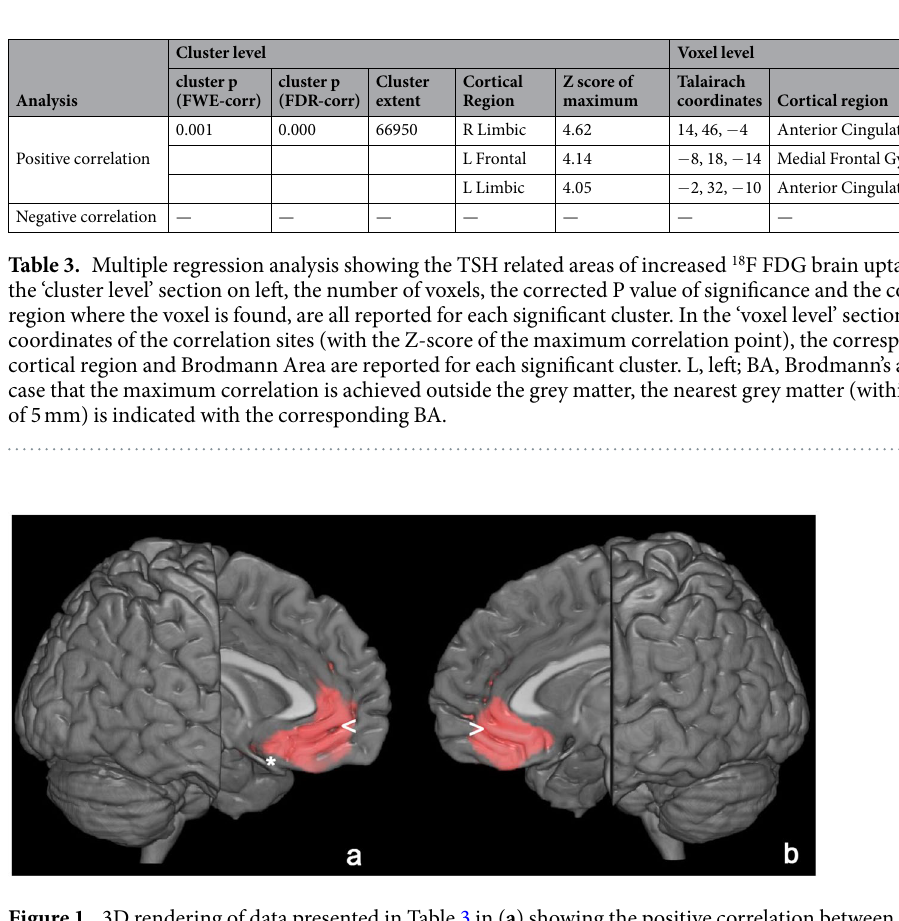
Figure 1. 3D rendering of data presented in Table 3 in ( a ) showing the positive correlation between TSH and brain glucose consumption in left anterior cingulate cortex ( < ) and medial frontal gyrus ( * ) and in the right anterior cingulate cortex ( b , > ). Threshold P < 0.01 corrected for multiple comparisons with false discovery rate at the voxel level. Coordinate and other regional details are presented in Table